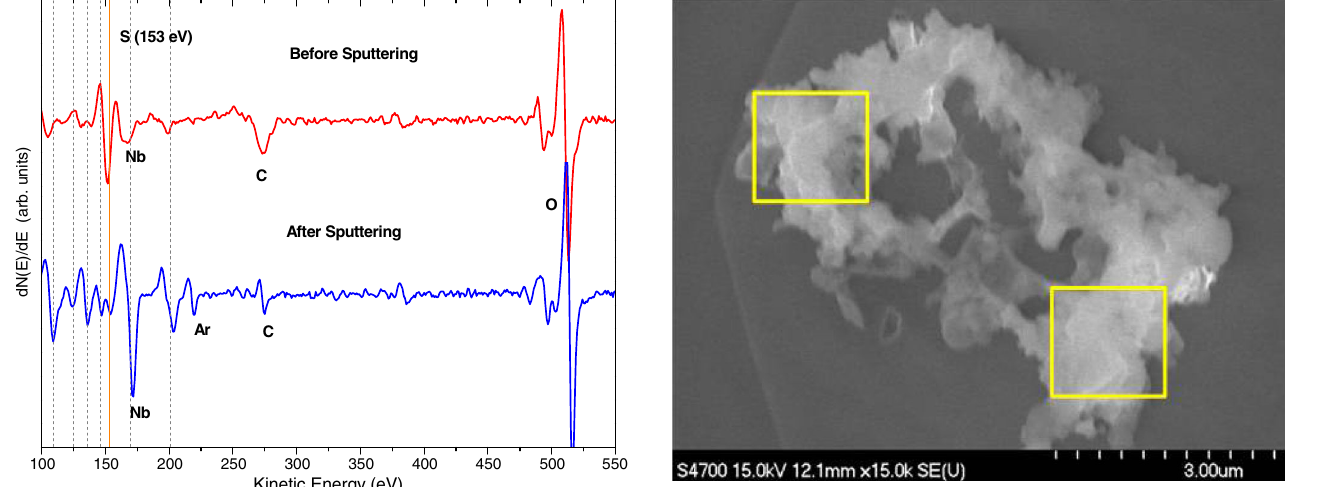
FIG. 8. AES spectra (scaled) of a spot before and after a slight sputtering. Fewer than ten atomic layers were removed by the Ar þ beam. The sulfur peak was greatly reduced after sputtering, which indicated sulfur coverage is